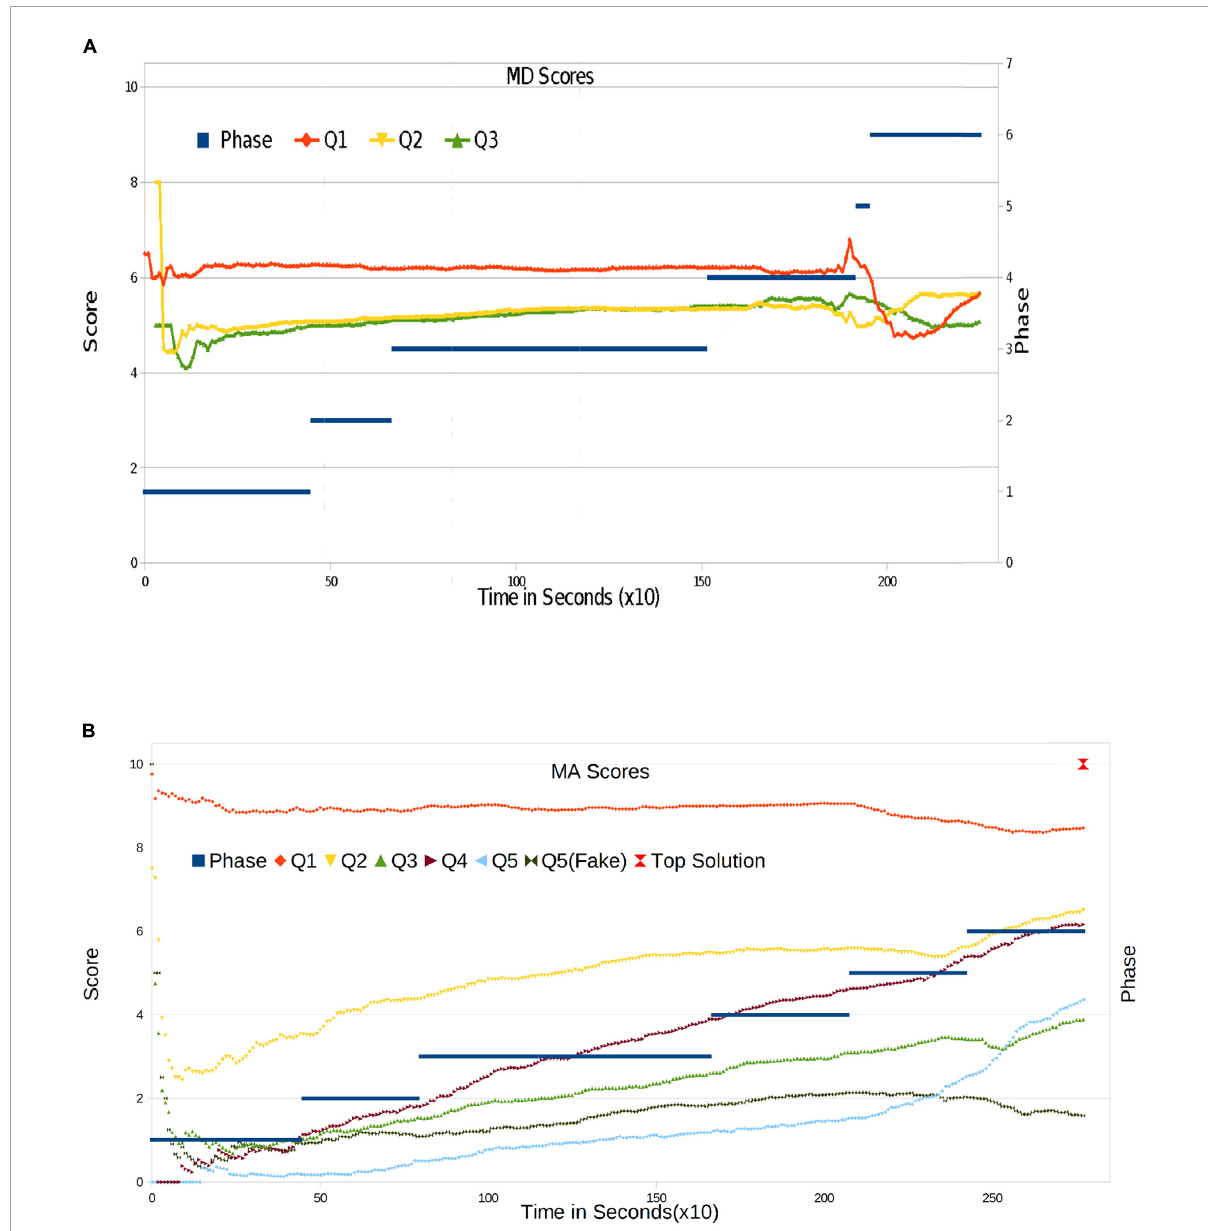
FIGURE4 (A) Individual question score evolution for MD. The maximum score is 10. (B) Individual question score evolution for MA experiment. The maximum score is